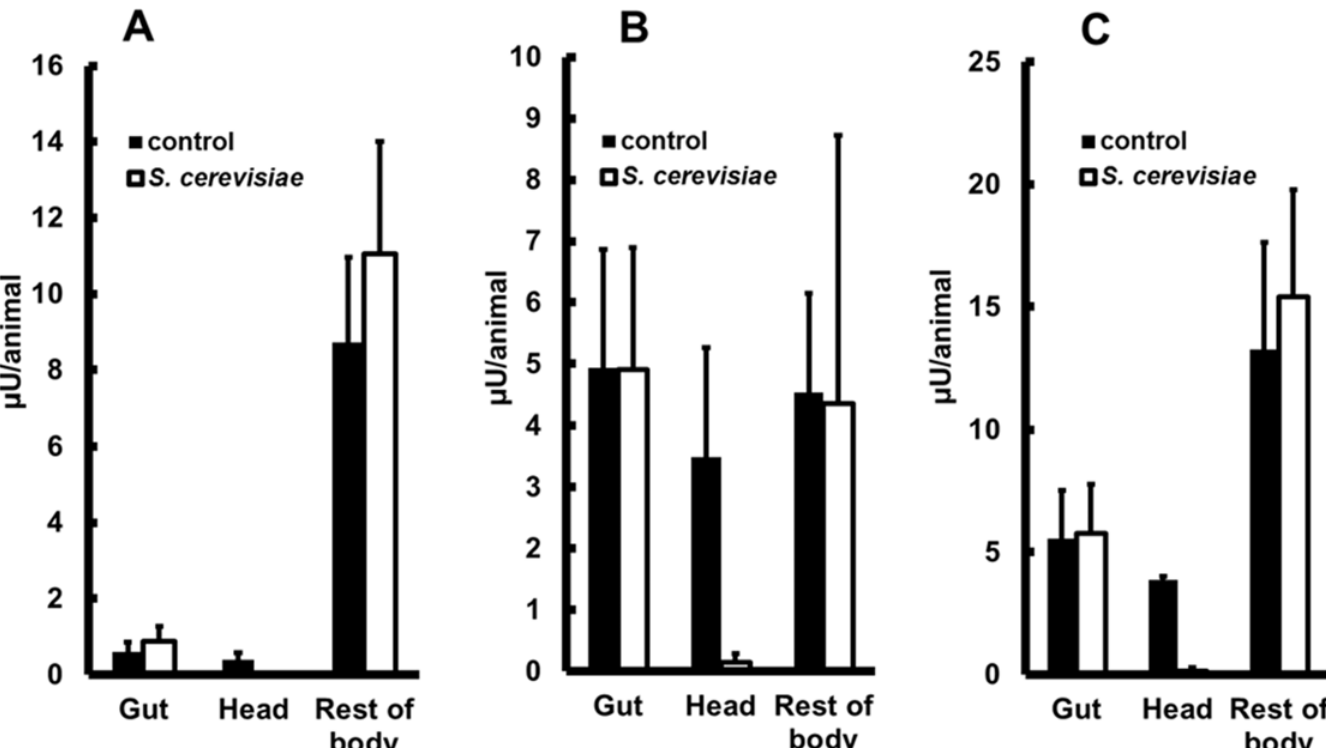
Fig 5. Beta-1,3-glucanase activity in heads, guts and rest of bodies of Aedes aegypti larvae fed on different diets. (A) Activities per insect ( μ U/animal) from soluble fractions of heads, guts and rest of bodies, (B) Activities per insect ( μ U/animal) from insoluble fractions of heads, guts and rest of bodies, (C) Total activities in heads, guts and rest of bodies (soluble plus insoluble fractions). Larvae were fed since egg hacthing exclusively with cat food (Whiskas 1 ) or autoclaved Saccharomyces cerevisiae cells. Figures are means ± SEM of 4 experiments with samples obtained from 50 insects each.